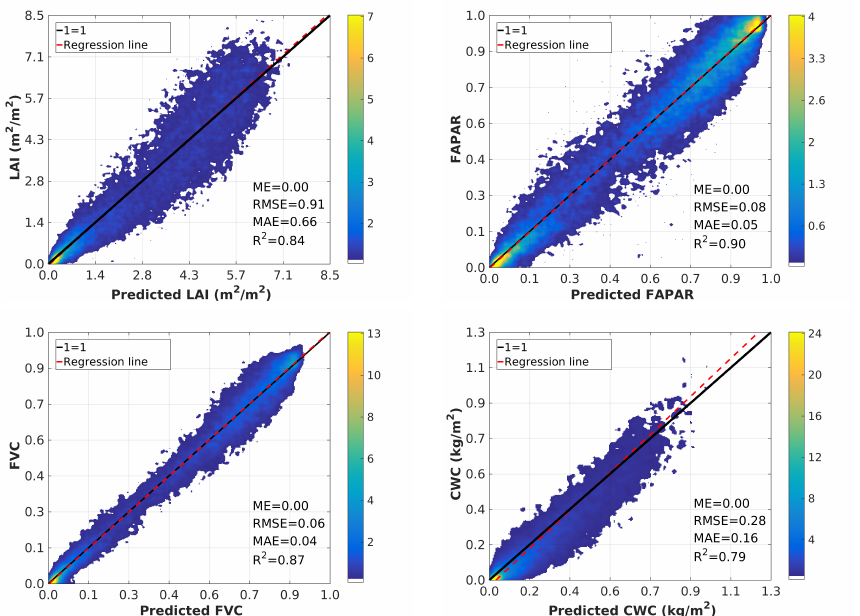
Figure 3. Theoretical performance of the Random forest regression over PROSAIL simulations of LAI, FAPAR, FVC and CWC. The colorbar indicates density of points in the scatter